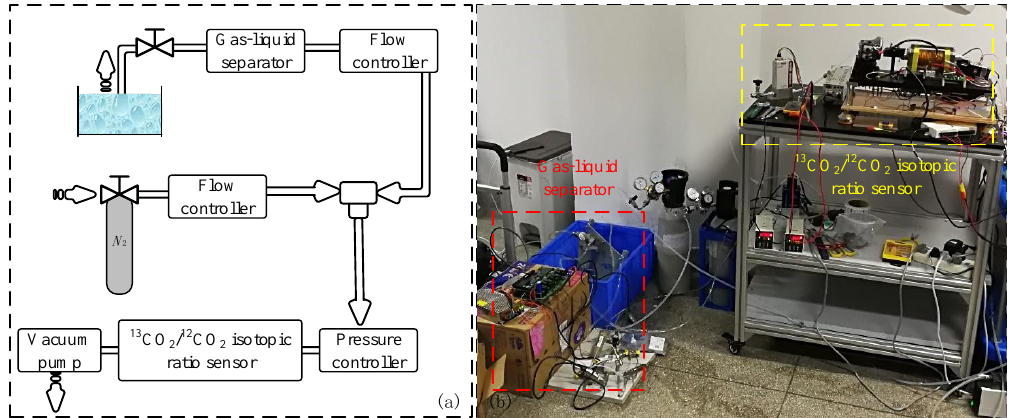
Figure 9. ( a ) Schematic block diagram of system configuration, and ( b ) physical image of the sensing system for deployment in the detection of dissolved CO 2 in water assisted by a gas – liquid separator and carrier gas.